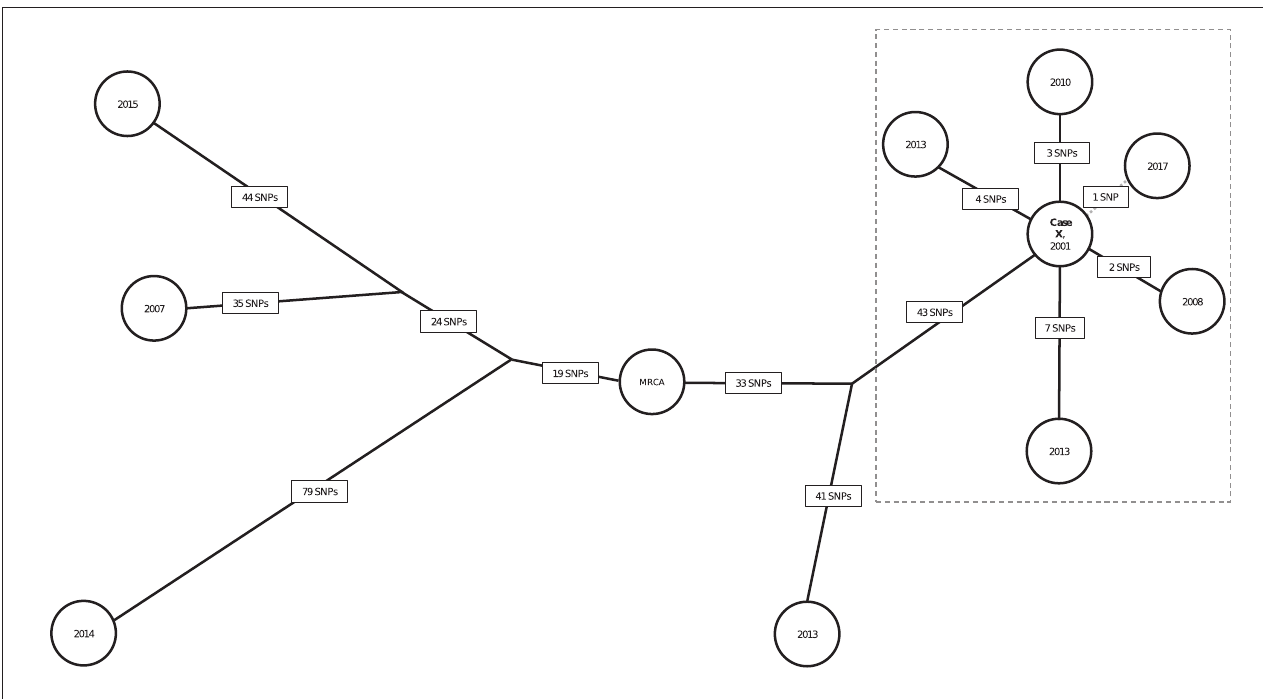
FIGURE 5 | Neighbor-joining tree (phylogenetic analysis) representing the genetic distances in single nucleotide polymorphisms (SNPs) among 10 genotype-matched isolates of Mycobacterium tuberculosis ( Mtb ), including isolates from a school-based cluster in California, 2001–2017 a . a Each node (circle) represents a patient’s Mtb isolate in the cluster. The year in each node corresponds to the year of TB diagnosis. SNP distances between each isolate are displayed in boxes on each branch. Bootstrap values obtained from 500 replicates were 100% for all branches. The isolates within the dotted box are the most closely related in the cluster and belong to patients for whom epidemiologic links were identified. Branch lengths were scaled proportionally among these isolates to improve visualization. Case X was diagnosed in 2001 and identified as the most likely source for 4 cases and a possible source for the fifth (2017) case in the dotted box; diagnosis dates for these cases ranged from 2008 to 2017. Solid black lines between Case X and other cases indicate that a definite or probable epidemiologic link was identified; the dotted line represents that a possible epidemiologic link (see Appendix Table 2 ) was identified. Three genotype-matched isolates not shown are from non-US–born patients whose TB was diagnosed elsewhere in the United States, indicating their cases are unlikely related to the cluster of